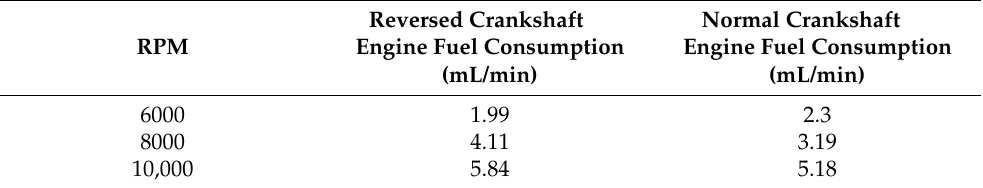
Table 1. Gas engine’s fuel consumption rates.